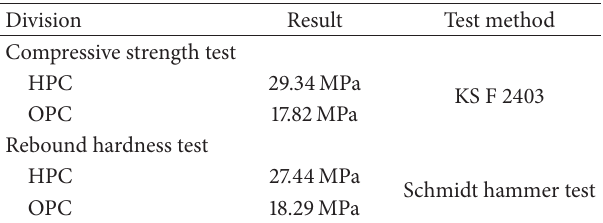
Table 4: Compressive strength of the concrete specimen.